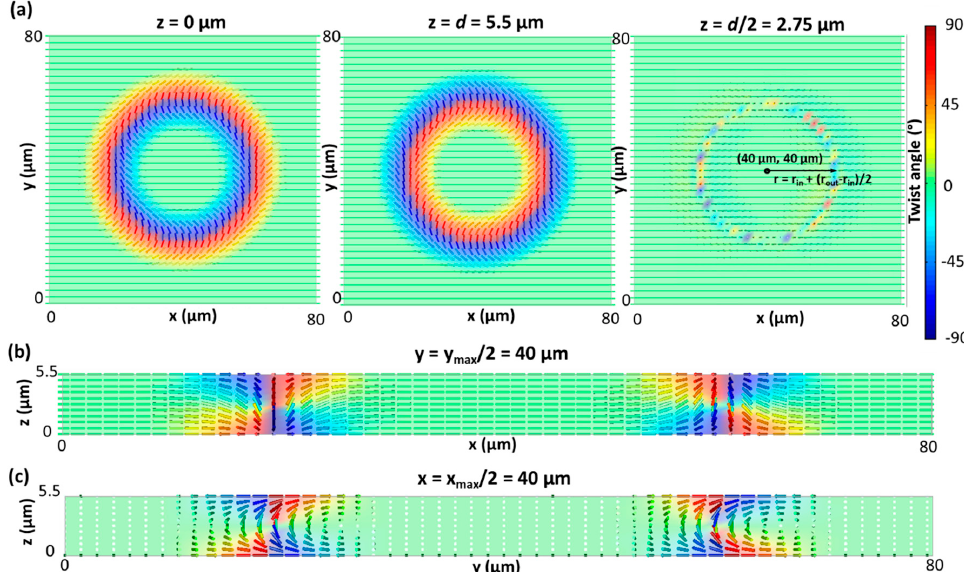
Figure 7. Simulated director configuration in configuration 1 (80 µ m × 80 µ m × 5.5 µ m unit cell) with a perfect overlap between the patterned rings at the top and bottom substrate (r out = 30 µ m, r in = 0.4 * r out ). The color represents the twist angle with respect to the x-axis. The director configuration is shown at the bottom substrate, the top substrate and the mid-plane z = d /2 ( a ), and in two perpendicular cross-sections y = y max /2 ( b ) and x= x max /2 ( c ).